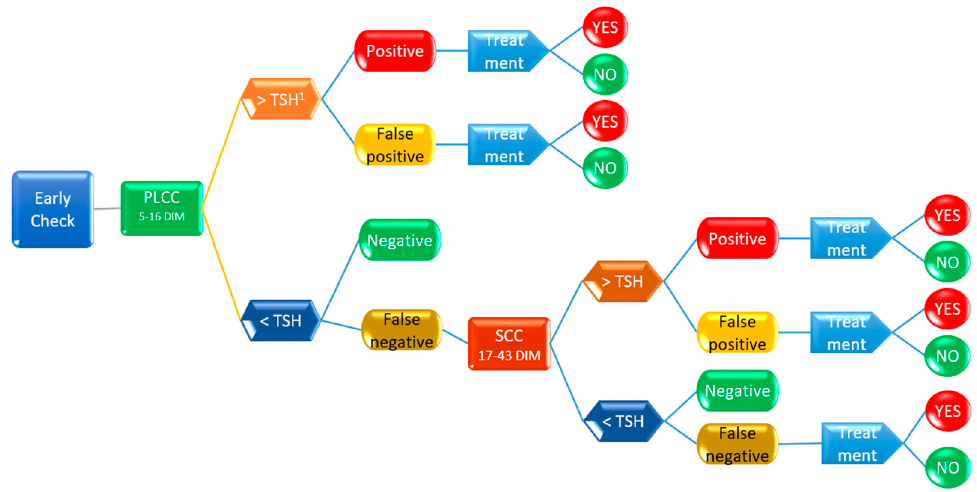
Figure 2. Summary of the decision tree model calculating the risk for intramammary treatment based on PLCC in the A period (5–16 days from calving). All the potential outcomes were considered for each of the nodes (positive, false positive, or negative), leading to the chances of a treatment. See Supplementary Figure S1 for the probability of each outcome. 1 TSH: threshold specific for each marker.